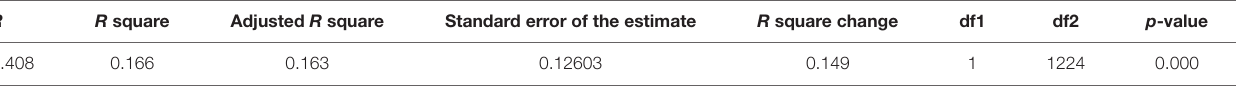
TABLE 6 | Model summary of regression of deviant behavior, personality traits and family satisfaction. R